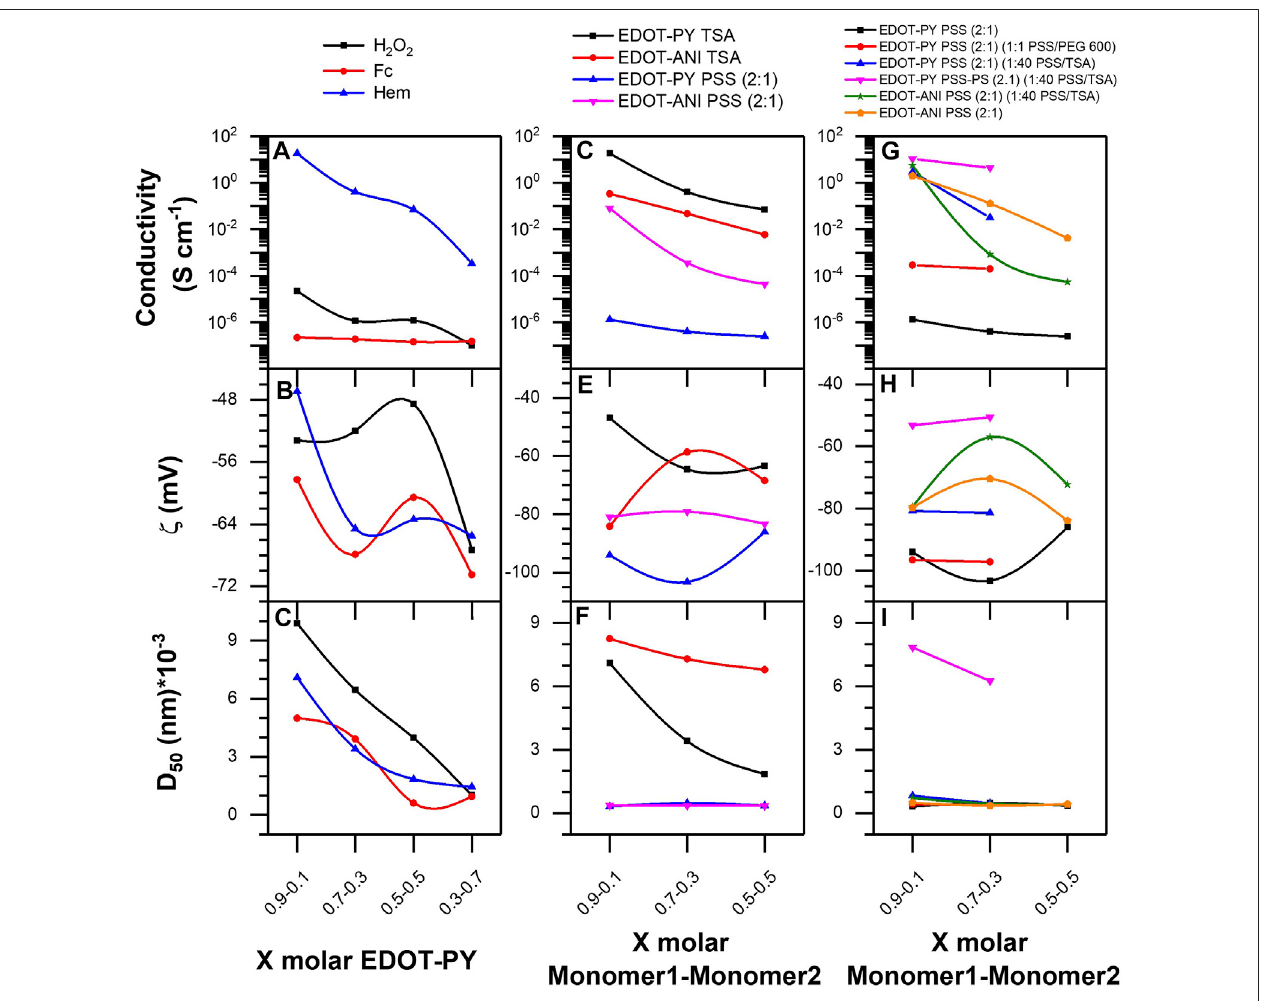
FIGURE 11 | (A) Conductivity, (B) Z-potential, and (C) average particle of EDOT-PY doped with TSA. (D) Conductivity, (E) Z-potential, and (F) average particle of EDOT-PY and EDOT-ANI doped with TSA and PSS. (G) Conductivity, (H) Z-potential, and (I) average particle of EDOT-PY and EDOT-ANI doped with PSS.